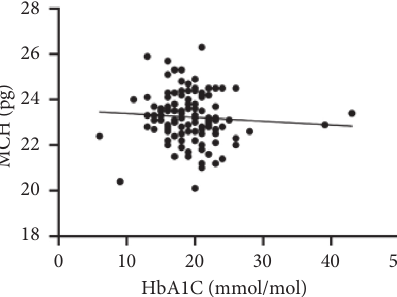
Figure 9: Relation between MCH and HbA1c ( r � 0.0047; p � 0 . 463).